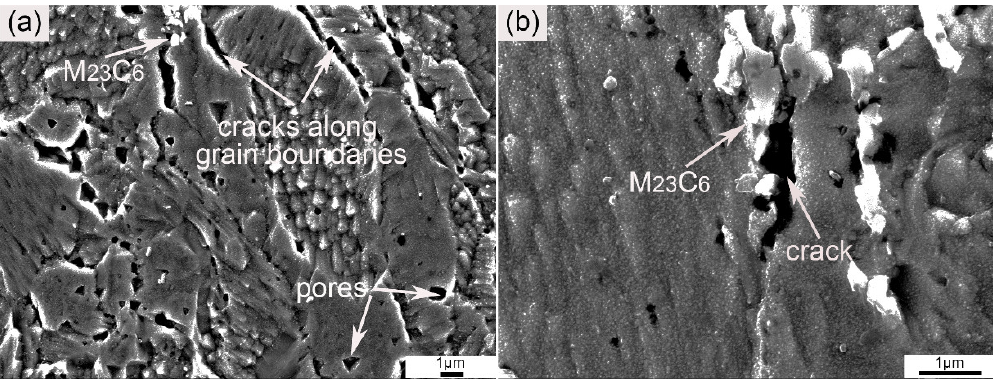
Figure 9. SEM graphs of cross-section morphology of the fracture at ( a ) low and ( b ) high magnification.